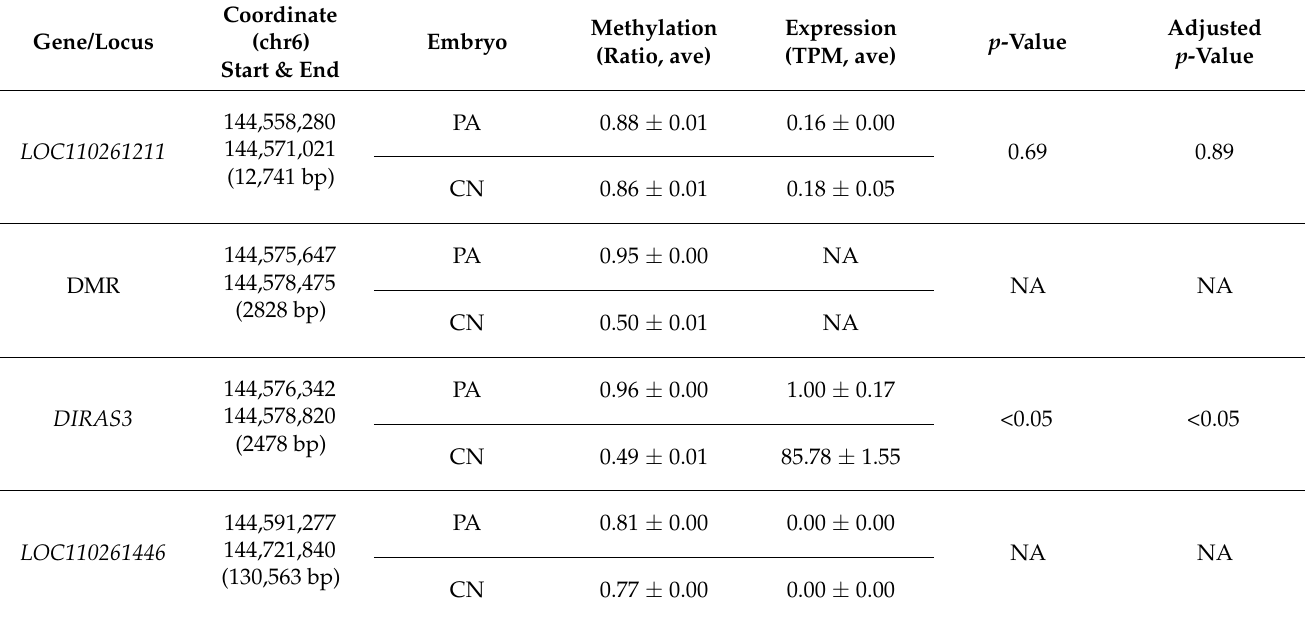
Table 1. DNA methylation and gene expression in PA and CN